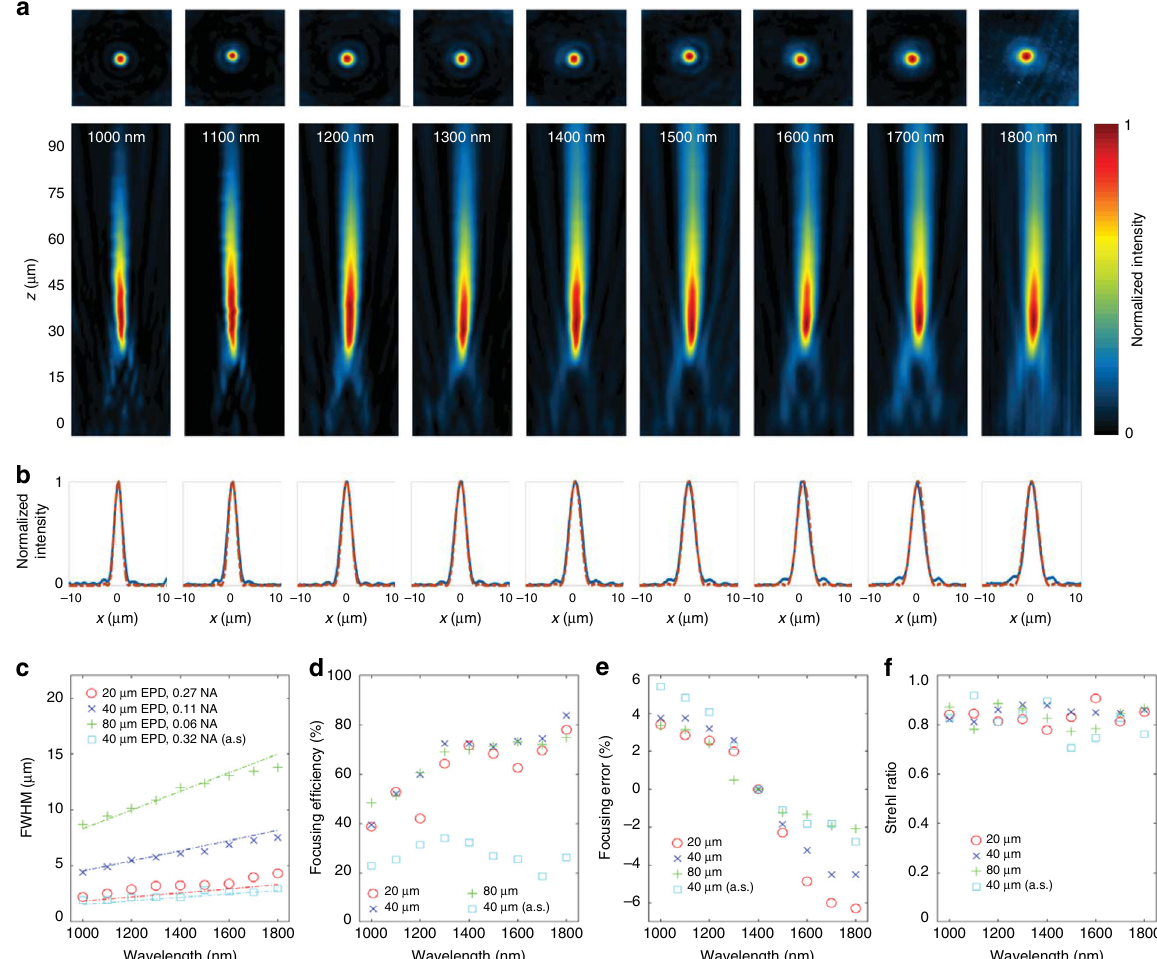
Fig. 4 Experimental characterization of hybrid achromatic metalenses. a Measured achromatic focusing of a collimated beam by a HAML (NA = 0.27, EPD = 20 μ m) located at z = 0. Intensity distribution in focal plane (top), and intensity distribution in plane containing the optical axis (bottom). The focal plane is 34.5 μ m from the lens. b Comparison of measured intensity (blue line) to Airy disk (dashed red line) at the focal plane. The lens is essentially diffraction limited at all wavelengths. c Comparison between diffraction limited and measured FWHM. Red, blue, cyan, and green dashed lines represent diffraction limited FWHM for 20, 40, 40 (air-spaced), and 80 μ m diameter lenses, respectively. d Focusing ef fi ciency vs. wavelength for four different lenses. e Focal length error measured as a function of wavelength for four different lenses. HAMLs improve focusing ef fi ciency while maintaining achromatic performance across the entire wavelength range. f Strehl ratio measurement results for four lenses. Source data are provided as a Source Data fi le for Fig. 4c